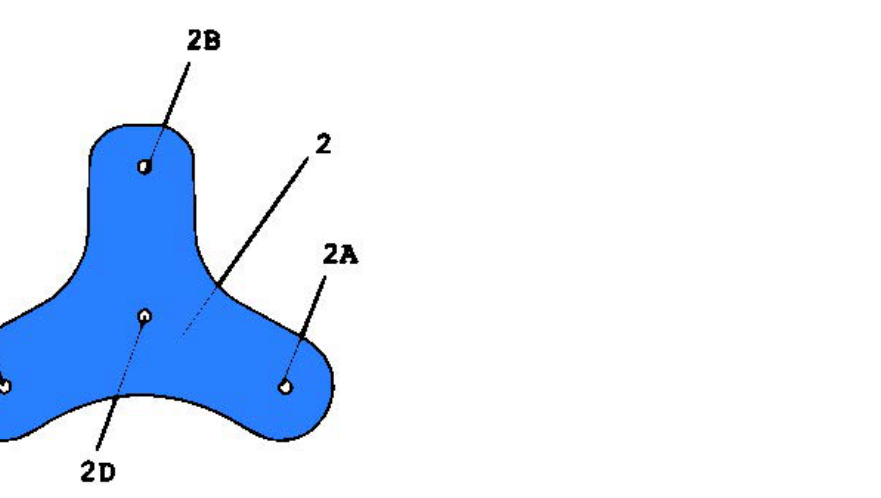
Figure 8. Propeller or fidget-spinner-like whippletree bar. The numbering (2) follows the conventions in Figure 2. The hole (2A) and the edge of the design are used for the "pin" for the ring and little fingers. The hole (2B) is for the thumb. The hole (2C) works similarly to (2A) but for the index and middle finger. The hole (2D) is for the main rope to the arm direction.